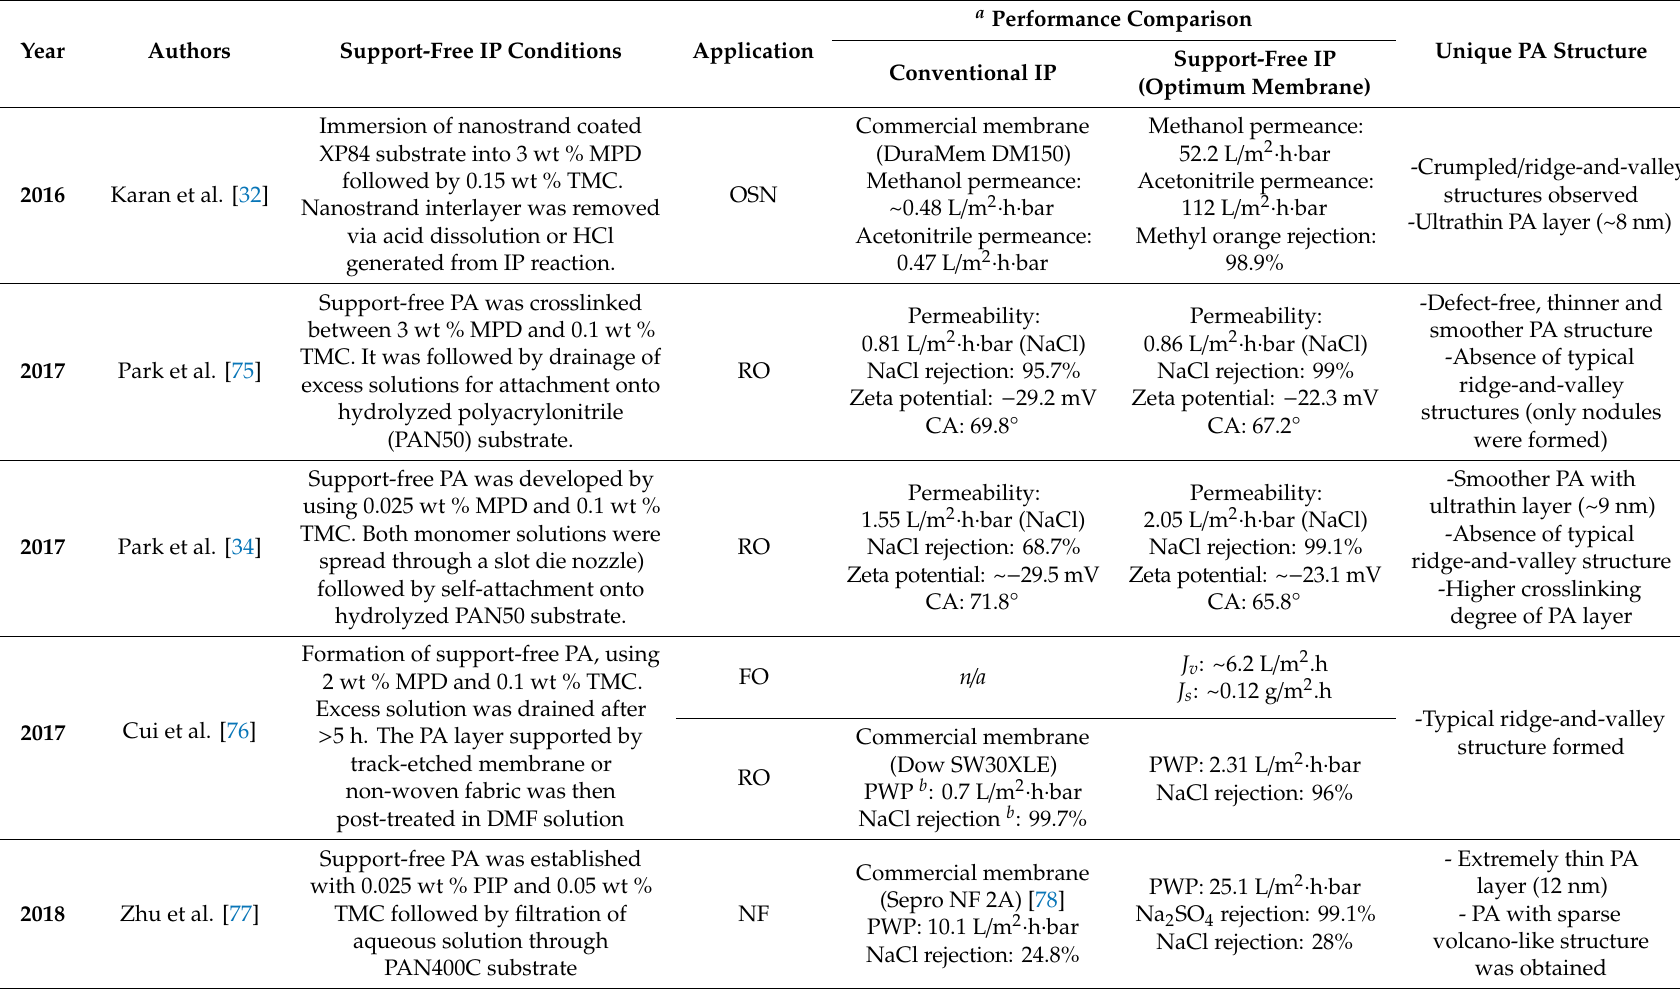
Table 1. Comparison of TFC membranes fabricated by using conventional and support-free IP